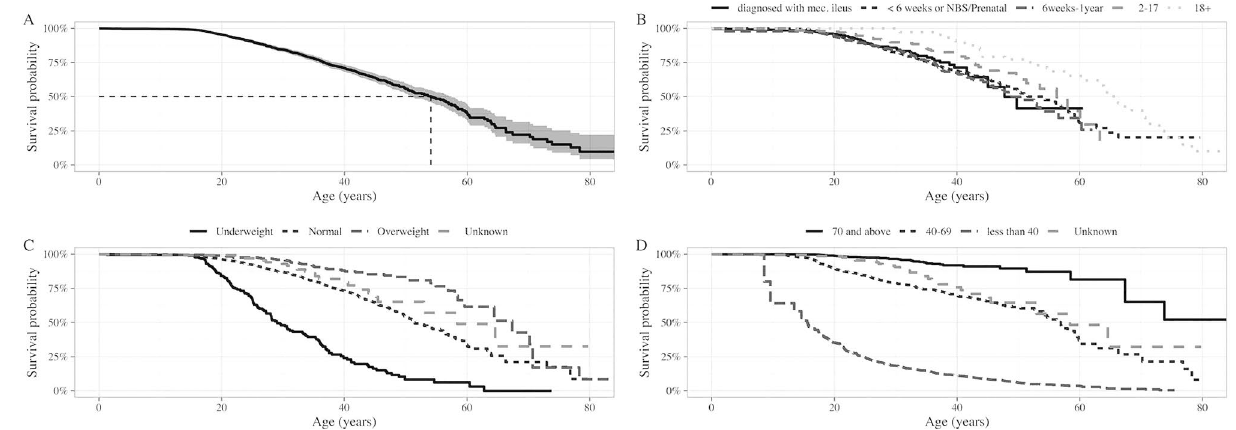
Figure 1. ( A ) Overall survival curve for people with cystic fibrosis, based on Kaplan–Meier estimates. ( B ) Probability functions depicting the age of people with cystic fibrosis by diagnosis category (with meconium ileus symptoms, under < 6 weeks or by NBS/prenatal screening, 6 weeks – < 2 years, 2–17 years and ≥ 18 years groups). ( C ) Probability functions depicting the age of people with CF by average lifetime lung function (FEV1 pp categories ≥ 70, 40–69, < 40). ( D ) Probability functions depicting the age of people with cystic fibrosis by BMI. Adult individuals (≥ 8 years) were classified into BMI categories based on World Health Organization